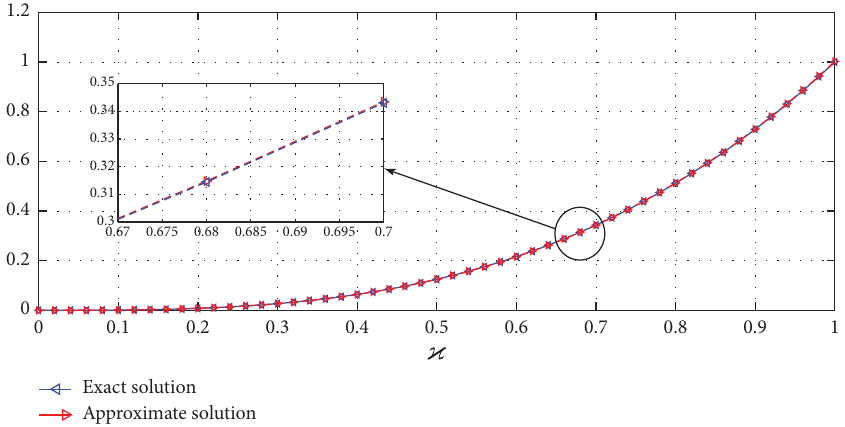
Figure 3: Exact and approximate solution for m � 6 for Example